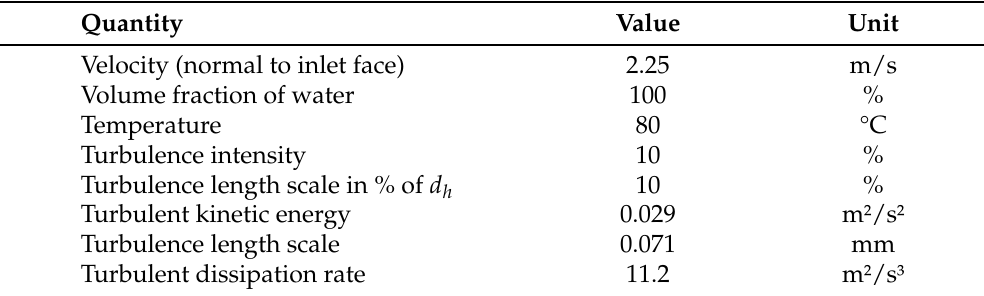
Table 4. Inlet Boundary